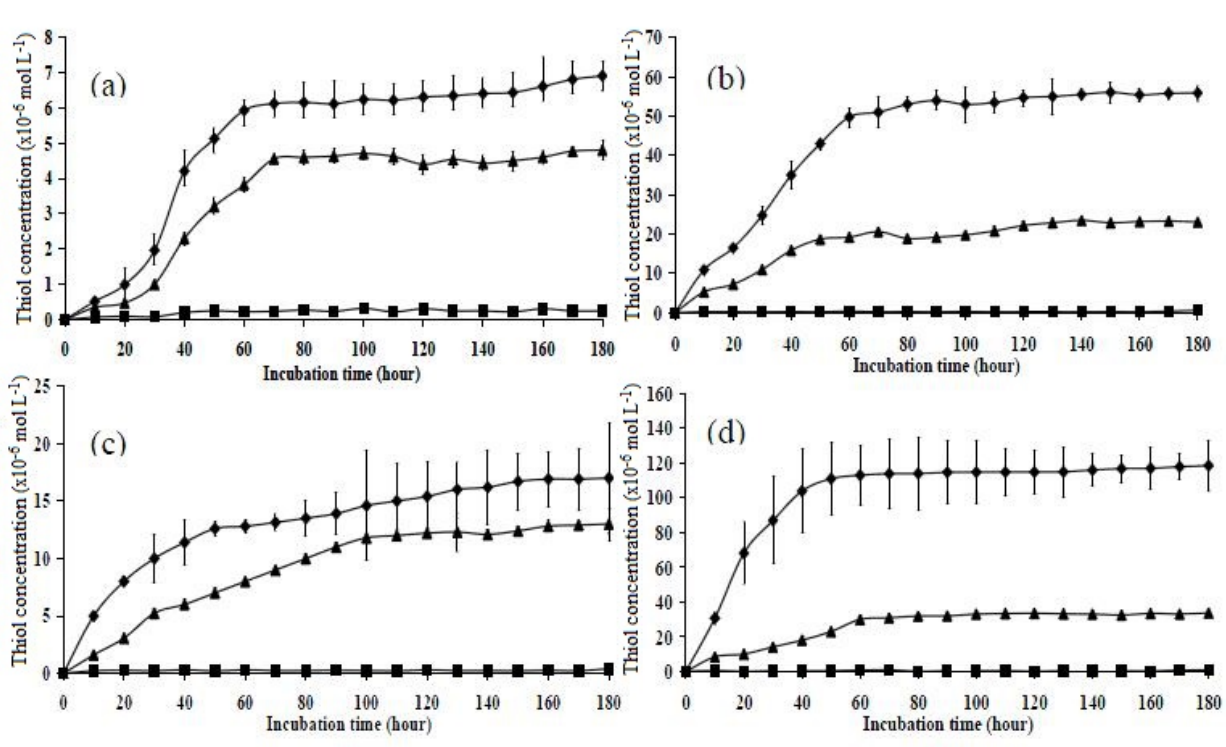
Figure 8. Thiol concentration as a function of incubation time in phosphate buffer medium over a 180 h time period in polymers ( a ) P10; ( b ) P11; ( c ) P151; and ( d ) P15. Mean ± SD, n = 6.